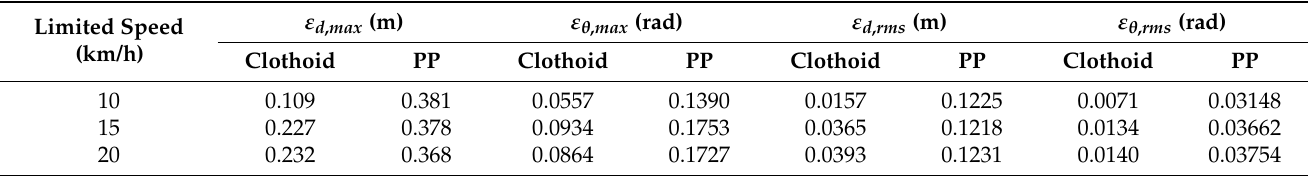
Table 1. Test result statistics. Clothoid represents the trajectory tracking control method based on the clothoid curve proposed in this paper. PP represents the pure pursuit tracking